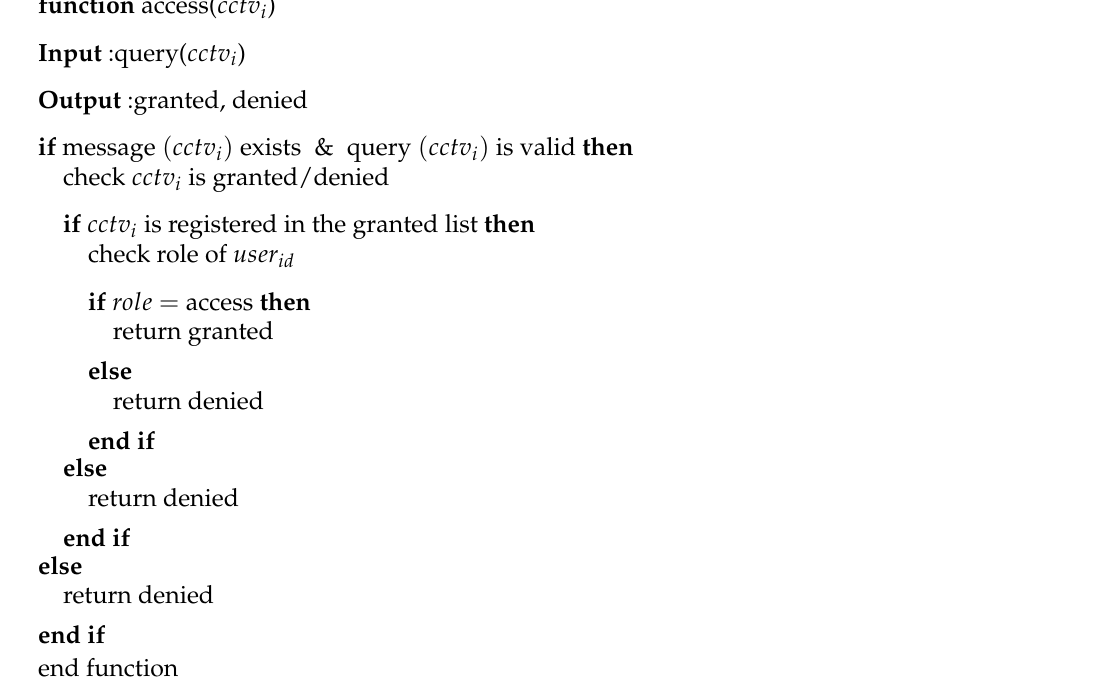
Algorithm 1 Smart contract algorithm for granting access for a particular user request. function access( cctv i